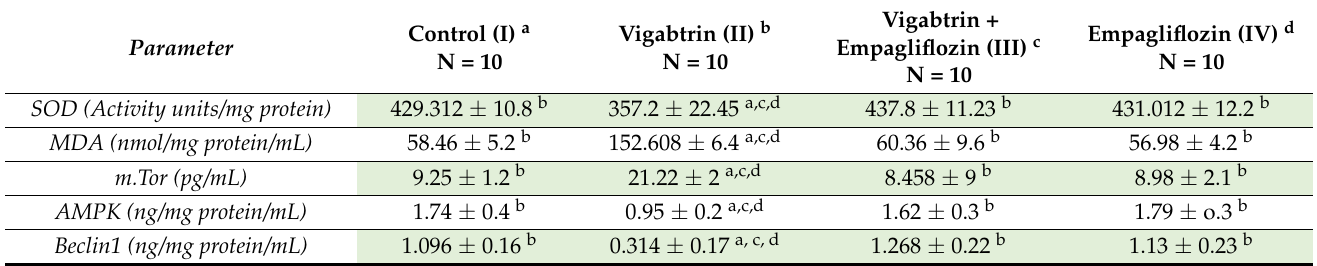
Table 2. Effect of Empagliflozin treatment on m.TOR, AMPK, Redox status, and autophagy among the studied